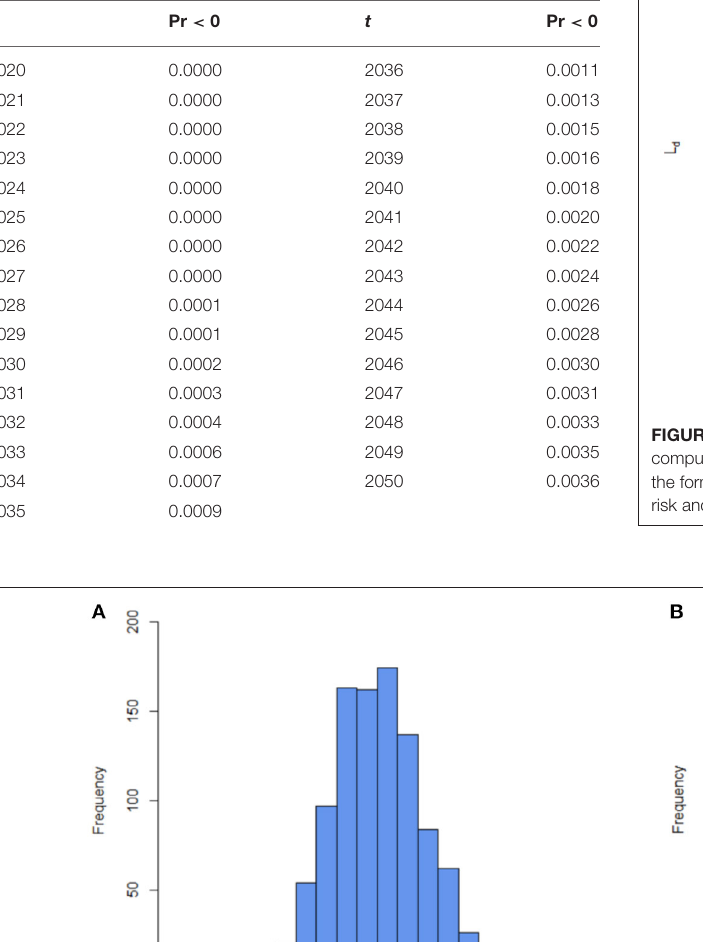
Frontiers in Public Health |